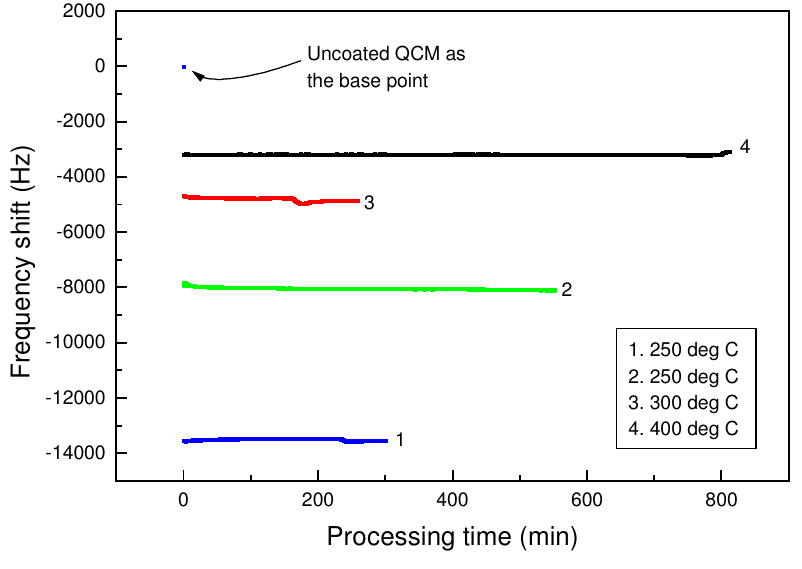
Processing time Figure 7 . Stability of the samples prepared with different annealing temperatures (all sample with the same annealing time interval of t=10min).